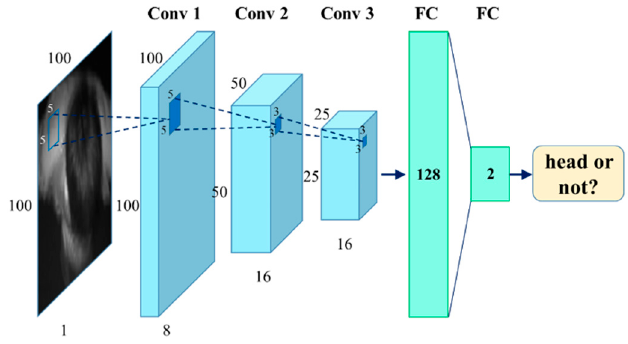
Figure 5. Architecture of the classification refinement network.